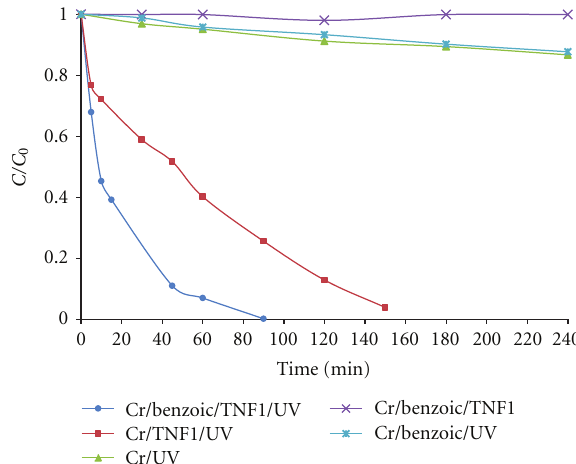
Figure 1: Photocatalytic reduction of Cr(VI) in single and binary systems. ([Cr(VI)] 0 = 0.1 mM, [BA] 0 = 0.01mM, pH = 2, N-F-TiO 2 = 500mg L − 1 ).